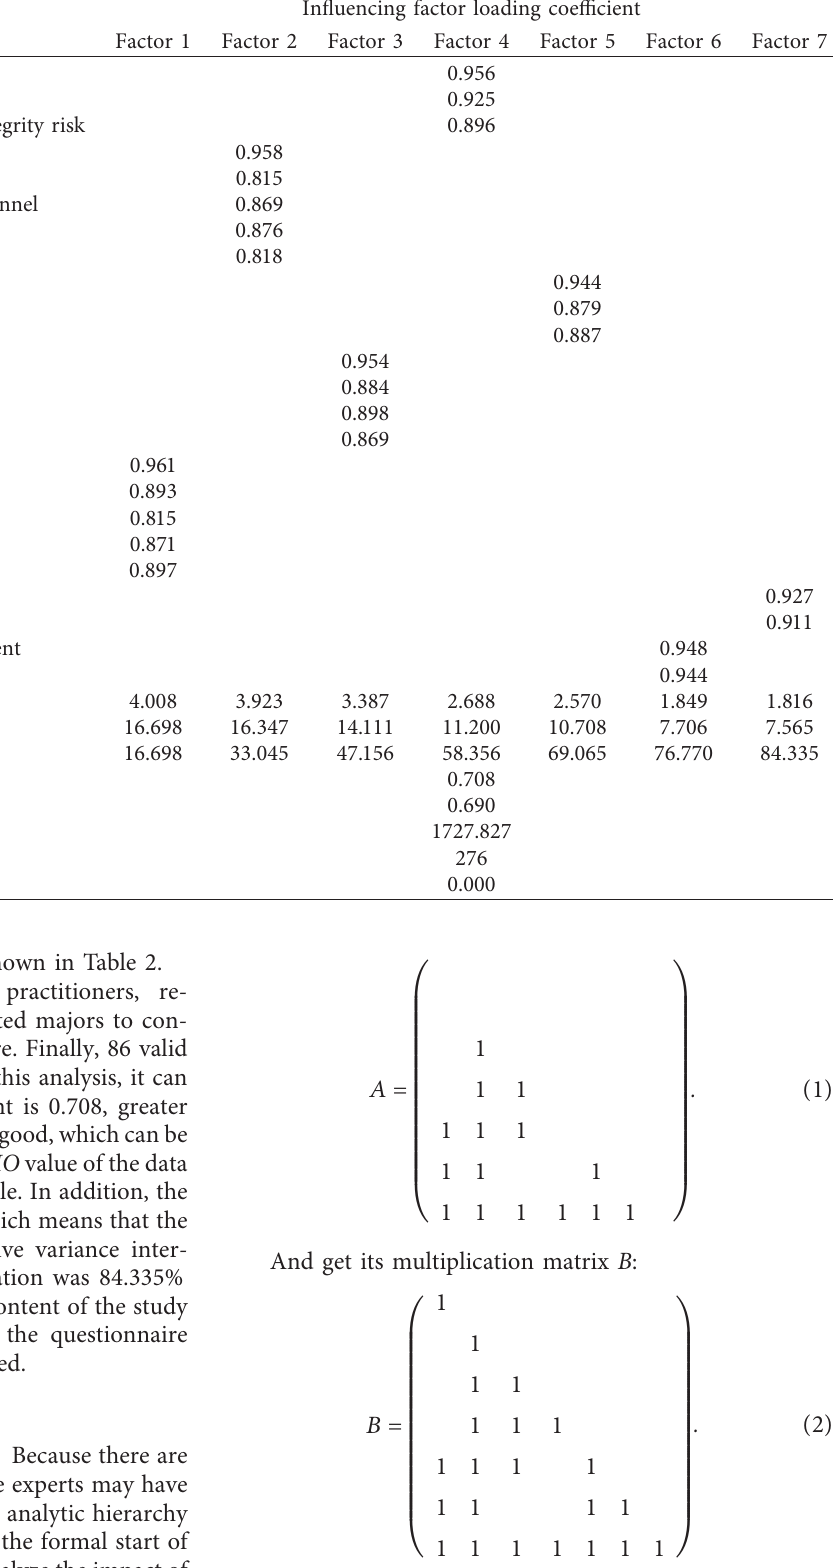
Table 2: Validity